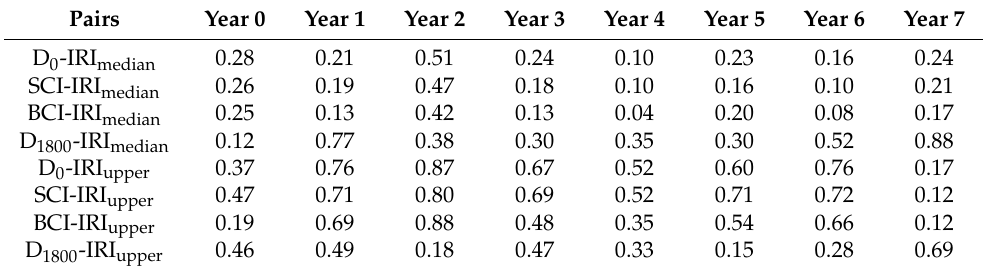
Table 5. R 2 value between Deflection-Based Parameters (DBPs) and IRI levels.